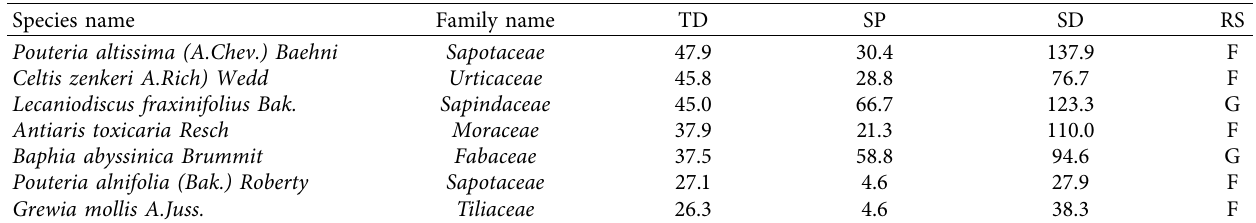
Figure 10: (a-e). Seedlings, saplings, and tree/shrub distribution of selected species occurring in each site of MFBR. (a) Cyathea manniana. (b) Pouteria altissima. (c) Vernonia hochstetteri. (d) Ficus mucuso. (e) Alangium chinense . Table 12: Regeneration status of top ten species in site II (Newi–Baya).